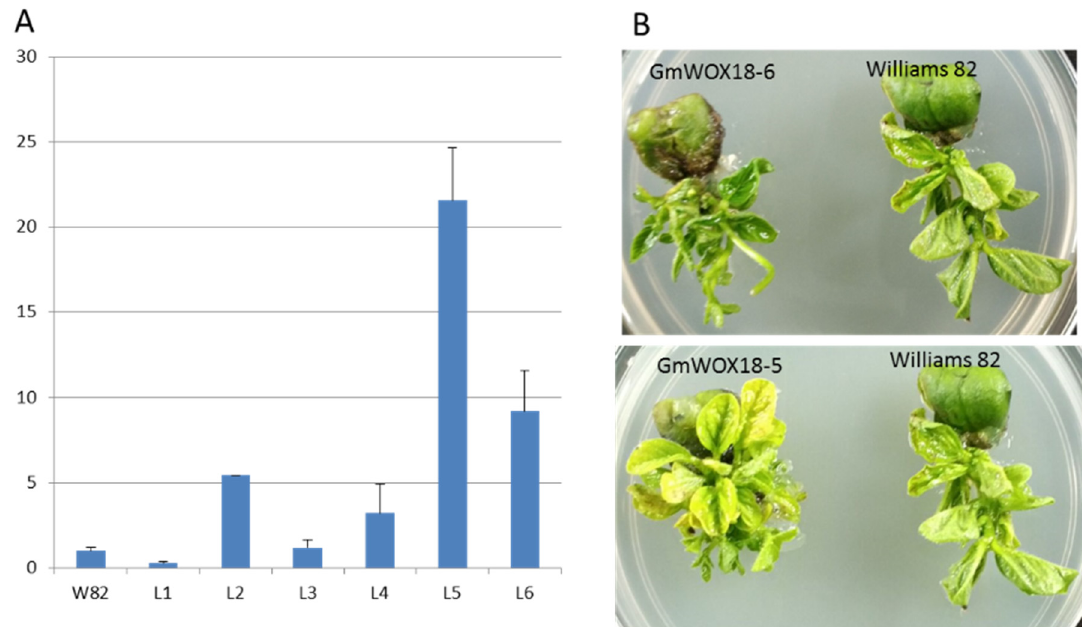
Figure 8. The regeneration ability of GmWOX18 transgenic lines. ( A ) RT-PCR testing of GmWOX18 transgenic lines; ( B ) Induction of cluster buds in transgenic lines.